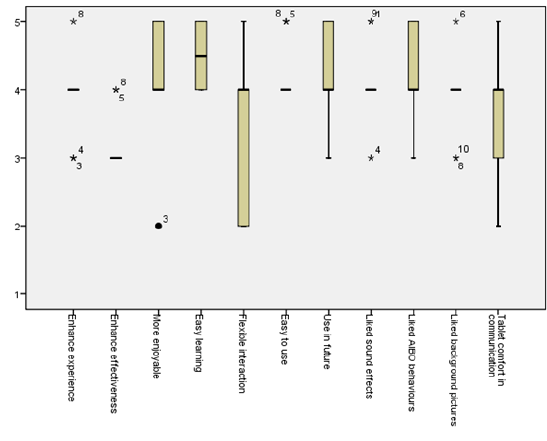
Figure 6. Custom story elements usage over the total 10 sessions. One group of users started with the no-AIBO mode (S1-S5) and progressed to AIBO mode (S6-S10) after the 5th session while the other group started with the AIBO mode (S1-S5) and progressed to no-AIBO mode (S6-S10) after the 5th session. No-AIBO->AIBO group indi- cates the transition from the conventional mode to the robot mode while AIBO->no-AIBO reflects the opposite.